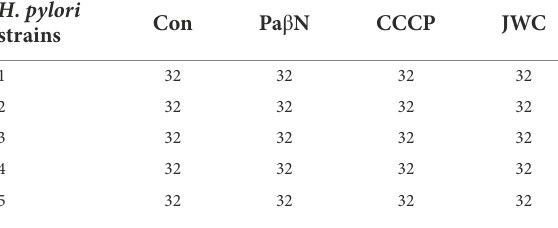
TABLE 5 Effects of JWC on MIC ( μ g/ml) of LEV resistant strains.